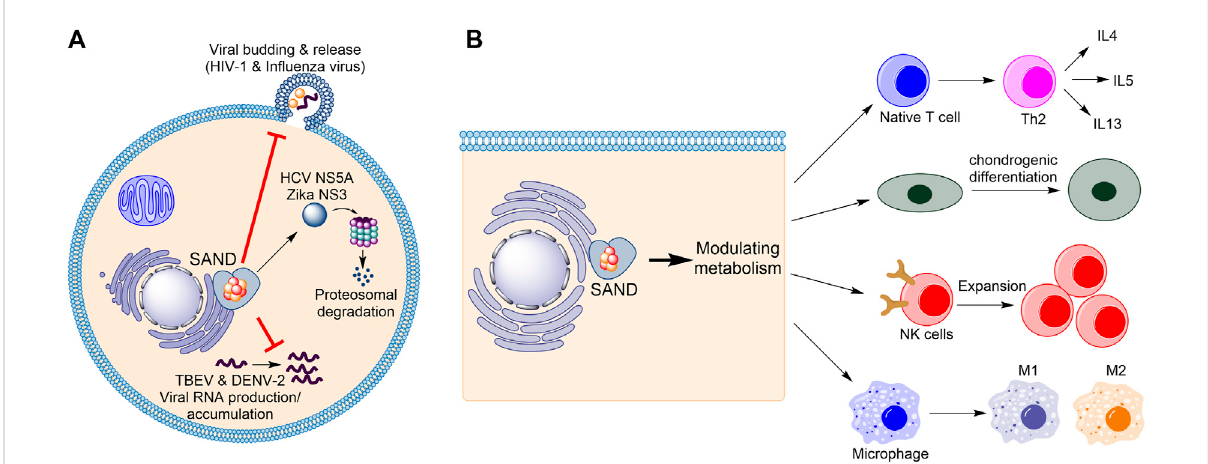
FIGURE 1 Human SAND has functions beyond its antiviral activity. (A) Various mechanisms of antiviral activity are proposed for human SAND. (B) Expression ofSANDaffectsthefunctionanddifferentiationofvarioustypesofcells.HCV,hepatitisCvirus;TBEV,tick-bornencephalitisvirus;DENV- 2, Dengue type-2 virus; NK, natural killer; IL,